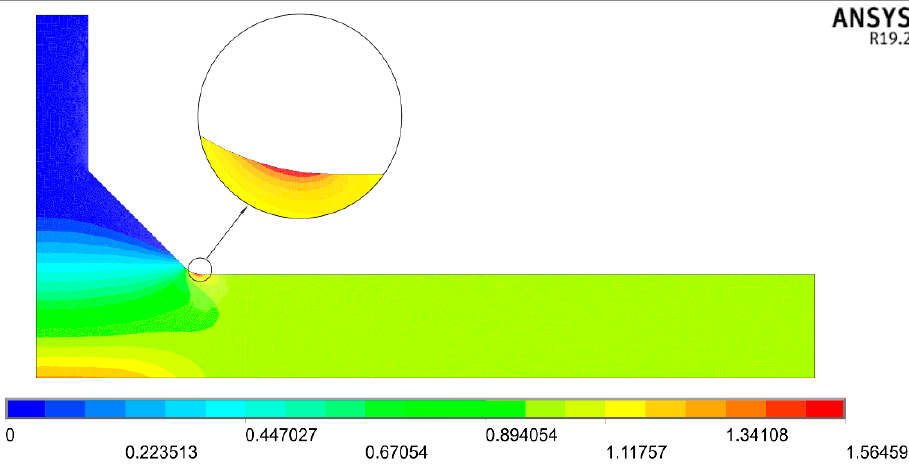
Figure 4. Distribution of the first principal stress σ 1 for σ t = 1 MPa, while θ = 45°, X = 0.25, Y = 0.415, and T / t = 1.